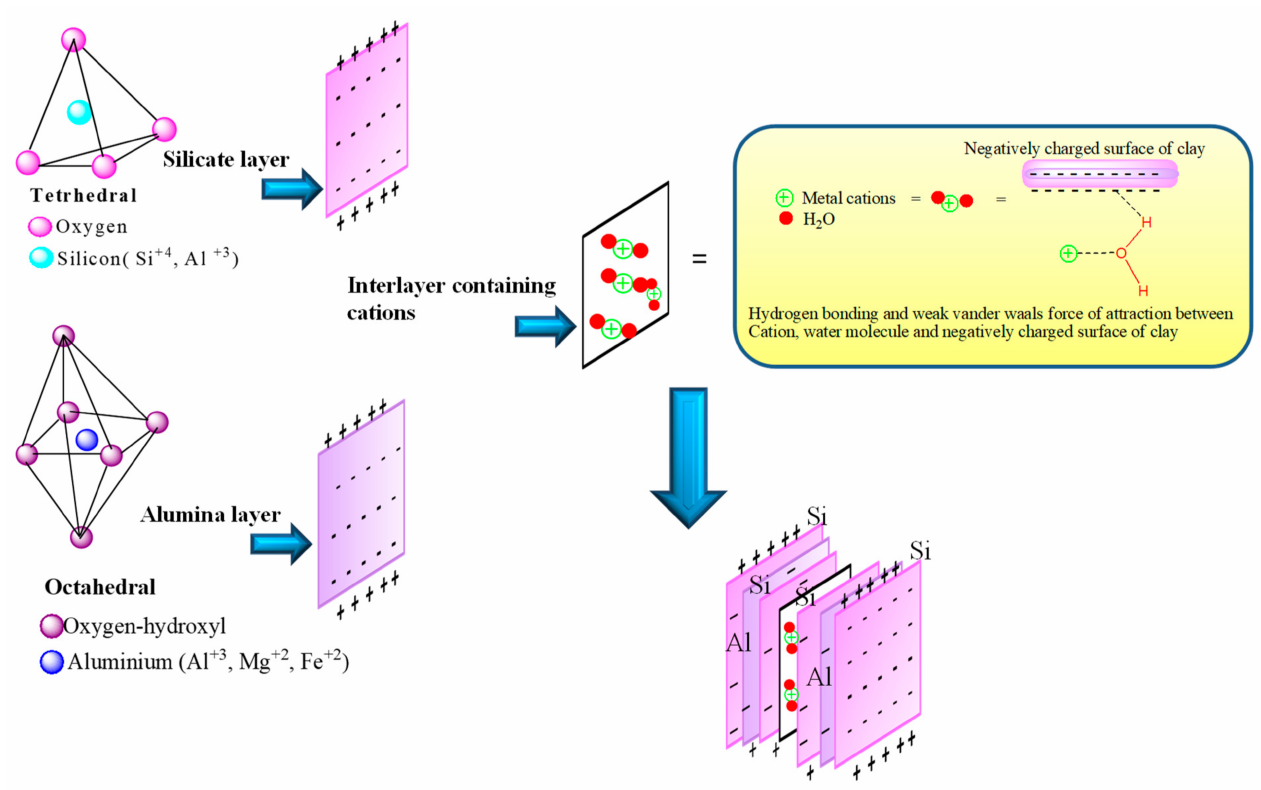
Figure 3. Structure of clay: Aluminosilicate layers with interlayers containing cations and water molecules.